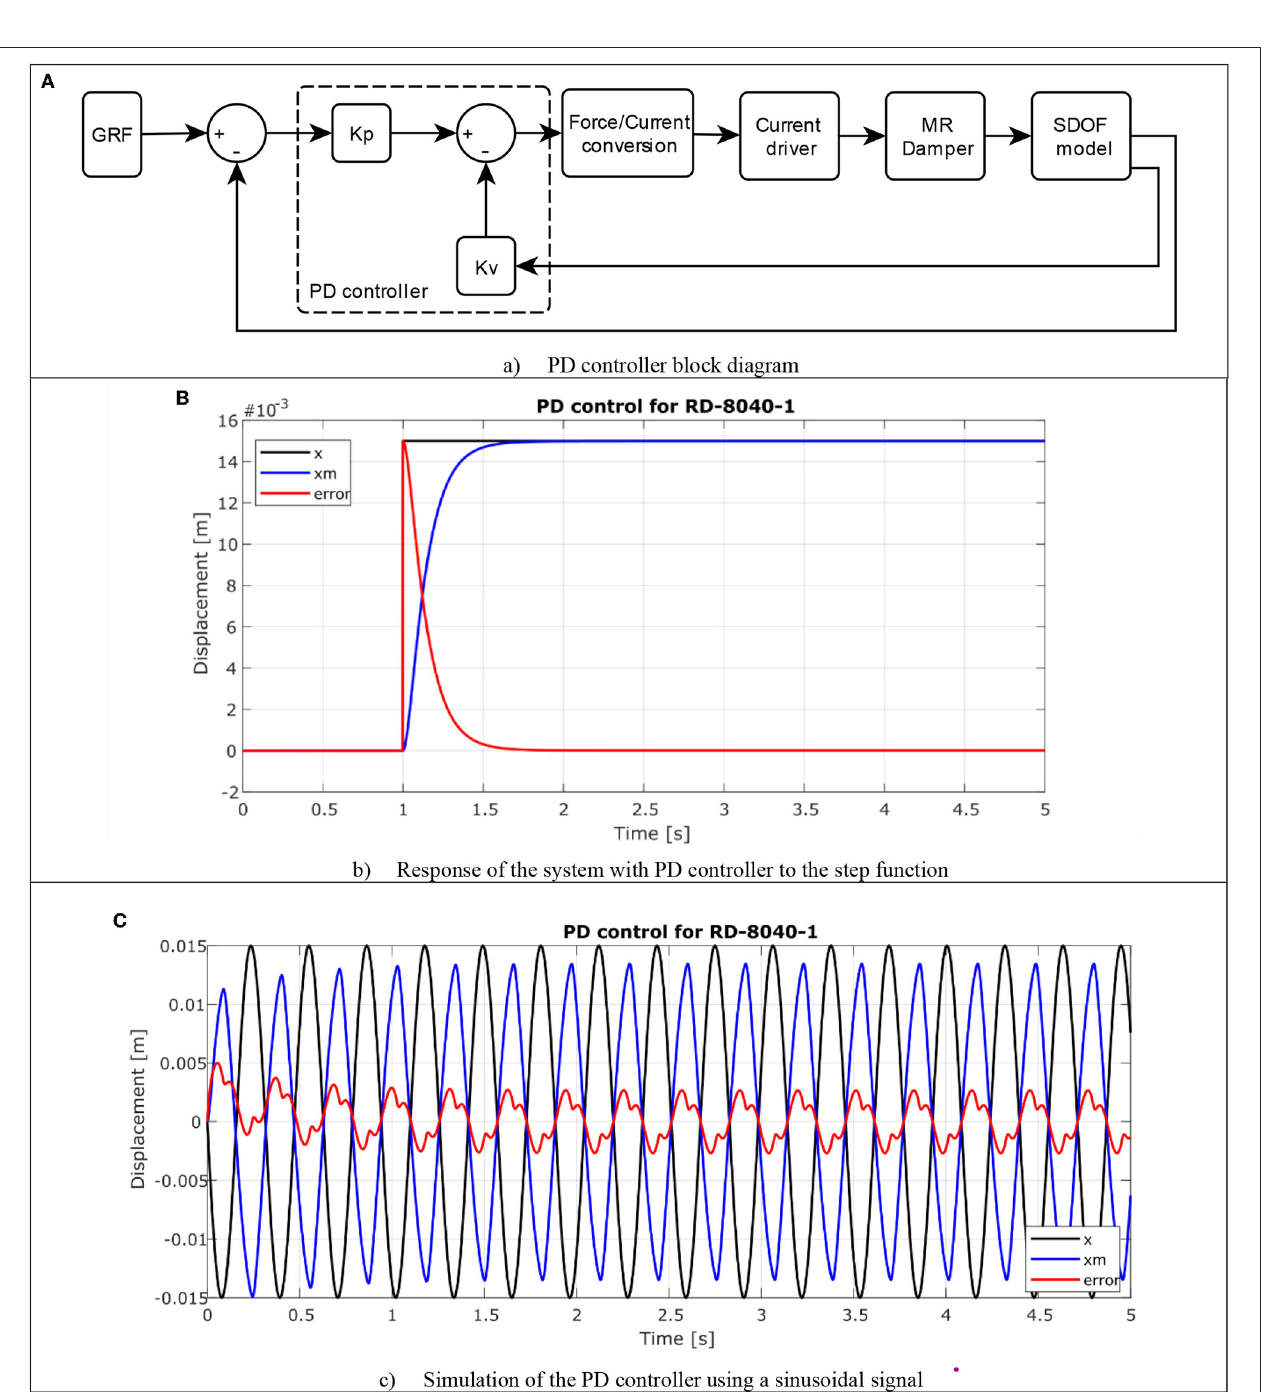
FIGURE 11 | Proportional-derivative controller. (A) PD controller block diagram. (B) Response of the system with PD controller to the step function. (C) Simulation of the PD controller using a sinusoidal signal.